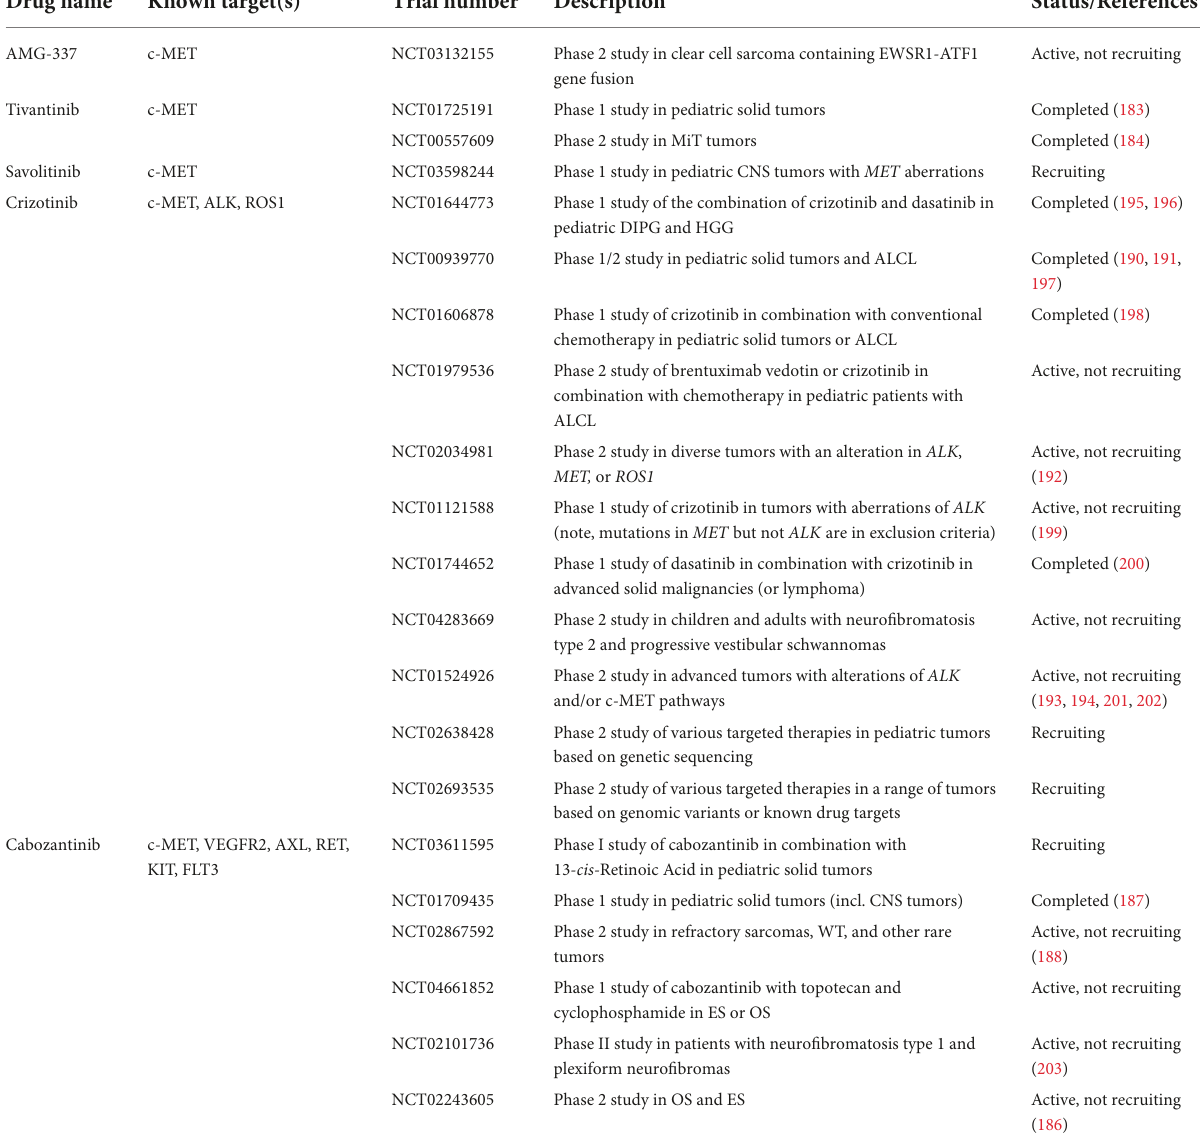
TABLE 2 Active, recruiting, or completed clinical trials of HGF/c-MET targeting agents that include pediatric